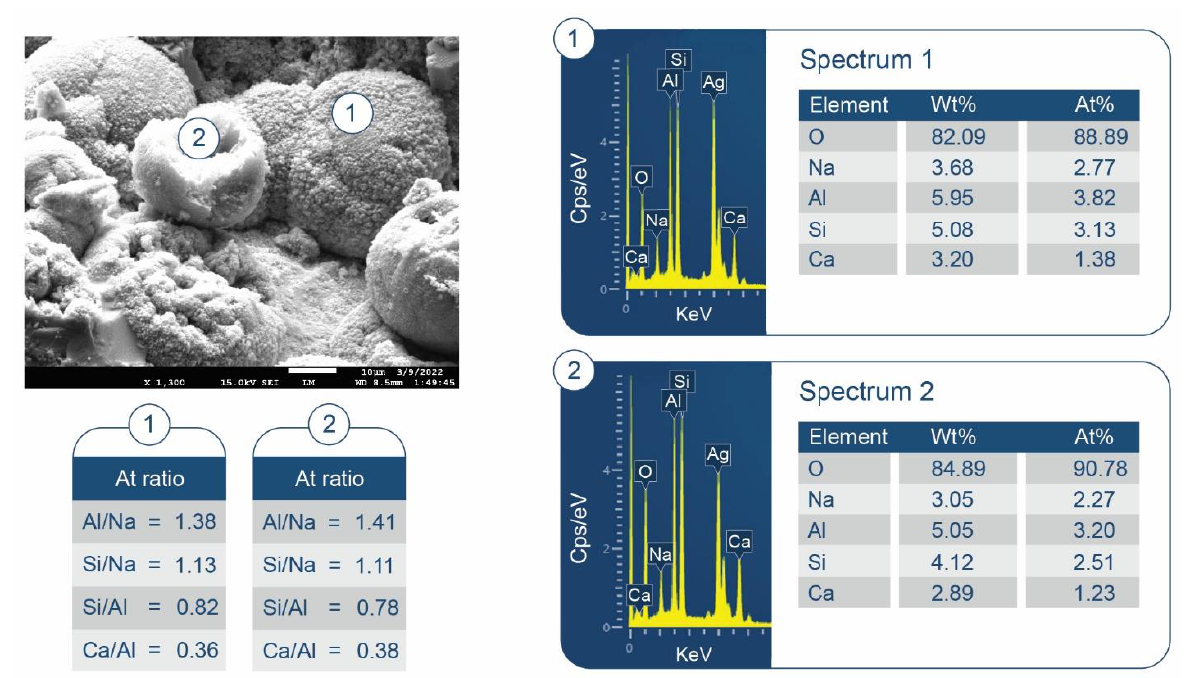
Figure 17. Photomicrograph of PR products of silica gel formed in a cavity of 250 °C-autoclaved Ca/HSA cement.